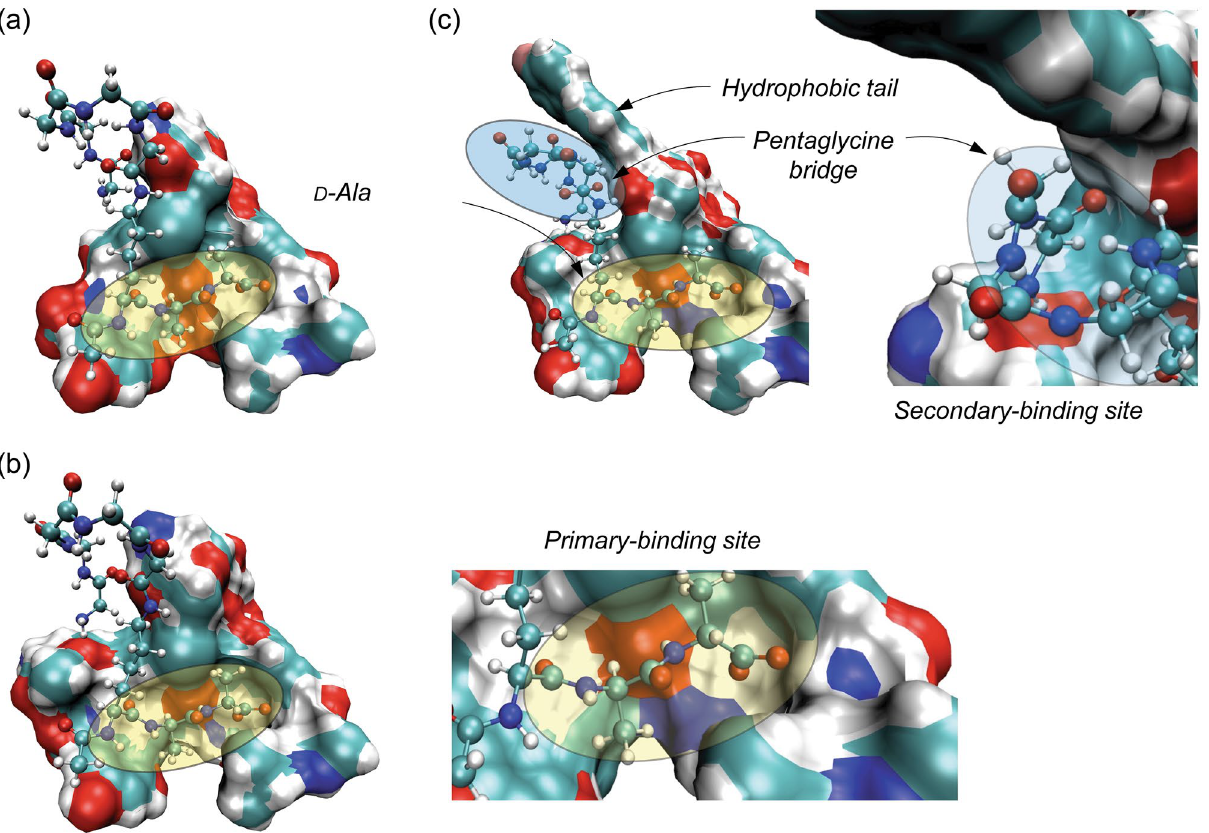
Figure 9. MD simulation model structures of the vancomycin–PG, chloroeremomycin–PG, and [ 19 F] oritavancin–PG complexes. ( a ) In the vancomycin–PG complex, the primary-binding site (yellow oval) at the heptapeptide-core of the aglycon is solely responsible for binding to the d-Ala-d-Ala terminus of the PG. ( b ) In the chloroeremomycin–PG complex, the presence of 4-epi-vancosamine attached to the 6th amino acid position enhances the PG binding. Even though chloroeremomycin does not have a secondary-binding site, the difference in the ΔG bind of chloroeremomycin–PG to vancomycin–PG complex (ΔΔG bind ) is − 16.29 kcal/ mol. ( c ) In the oritavancin–PG complex, both primary and secondary-binding sites contribute to the PG binding. The total number of H-bonds formed between the PG and oritavancin is 5.5 which is identical to the number of H-bonds found in the vancomycin–PG complex. But, unlike vancomycin and chloroeremomycin, the secondary-binding site (blue oval) significantly enhances the binding of oritavancin to PG by ΔΔG bind of − 37.83 and − 21.53 kcal/mol in comparison to vancomycin and chloroeremomycin, respectively (Table 2). This enhancement is due to an increase in the ΔG bind by electrostatic and van der Waals interactions between the drug hydrophobic sidechain with the pentaglycine-bridge structure of the bound the time evolution of the MD simulation. A 2D rmsd contour plotted by comparing the binding distribution of the Ori–PG complex to that of the other complexes using their rmsd values (Fig. 5) further confirmed that the